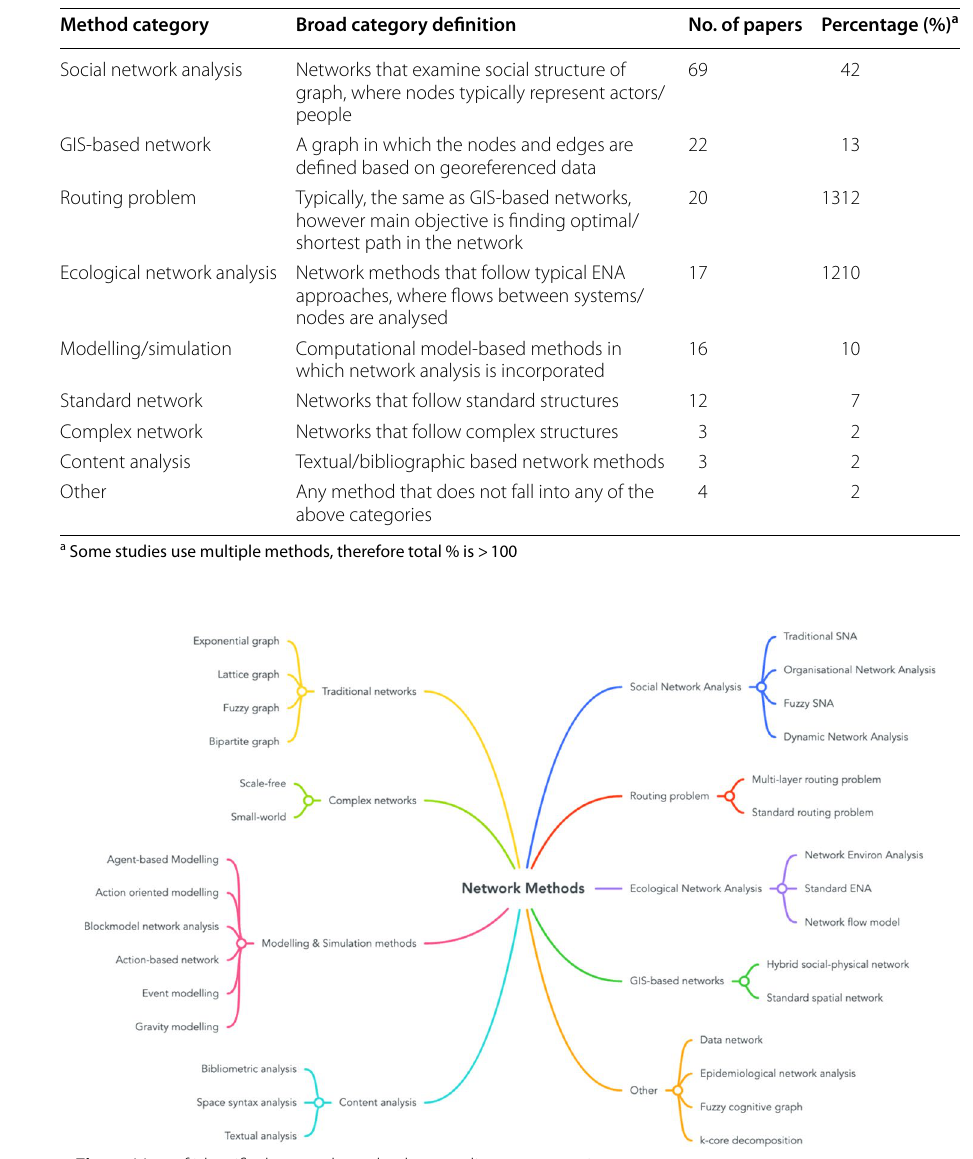
Table 2 Network analysis methods